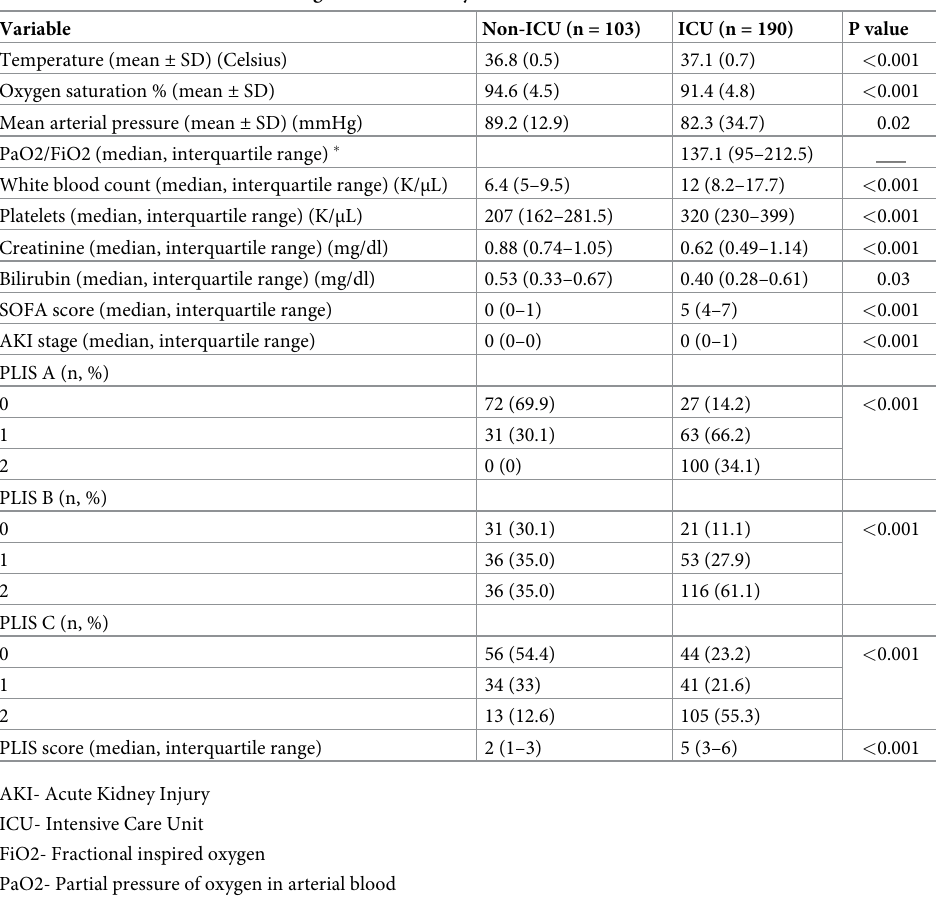
Table 3. Clinical characteristics during PLIS stratified by intensive care unit versus nonintensive care